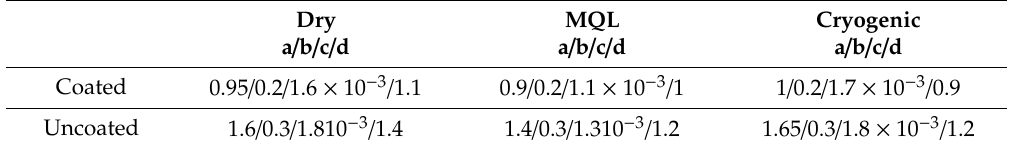
Table 2. Values for roughness constant C in varying lubro / cooling and coating